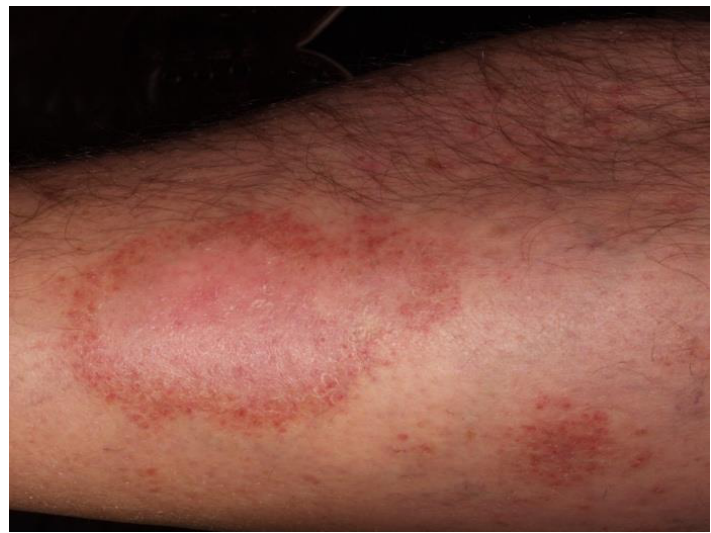
Figure 3 . Purpura annularis telangiectodes of Majocchi. Annular plaques with central atrophic area and cayenne pepper petechiae in the border.